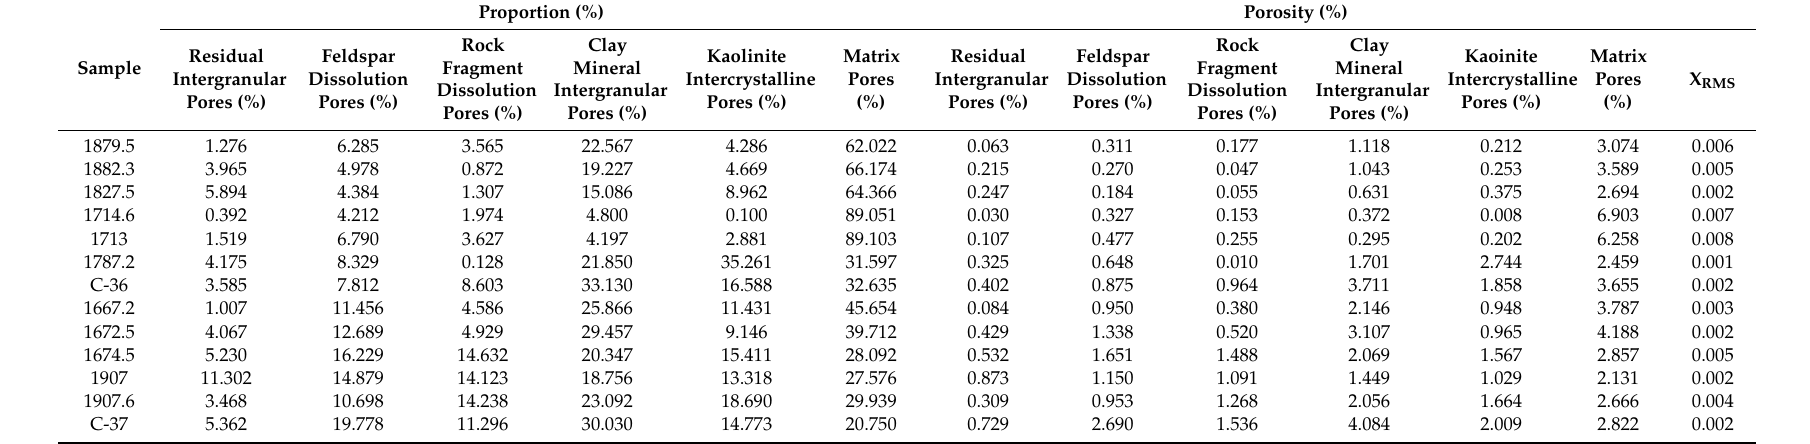
Table 2. The proportion and porosity of di ff erent pore types in the J 1 b